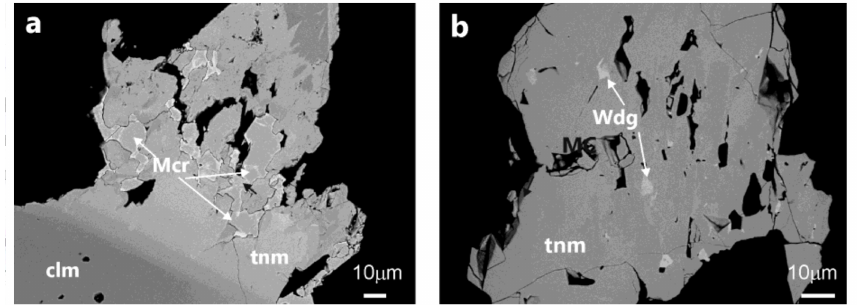
Figure 4. Microlite ( a ) and wodginite ( b ) from the Penouta open pit leucogranite. Mcr, microlite; Wdg, wodginite. clm, columbite-(Mn); tnm, tantalite-(Mn).